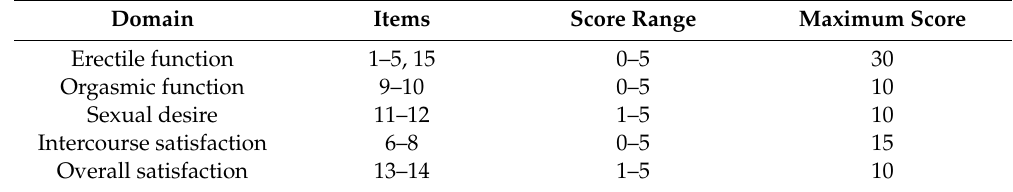
Table 1. Items and the scores of the International Index of Erectile Function (IIEF)